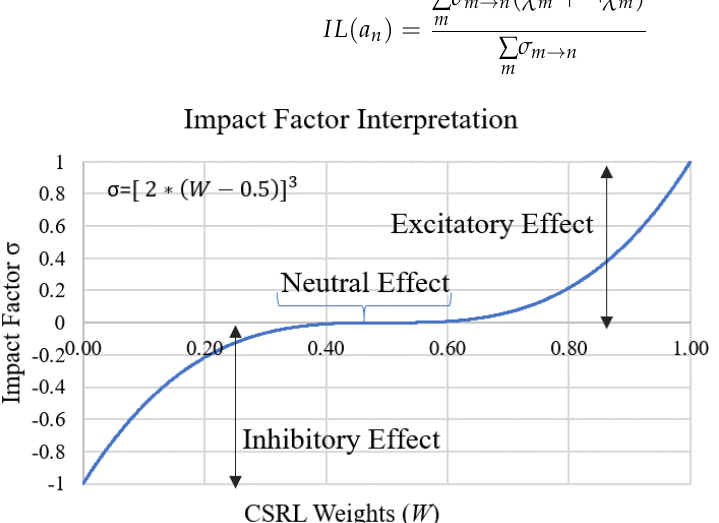
Figure 6. Excitatory, inhibitory, and neutral effect of CSRL weights (W) when transformed using the impact factor σ .